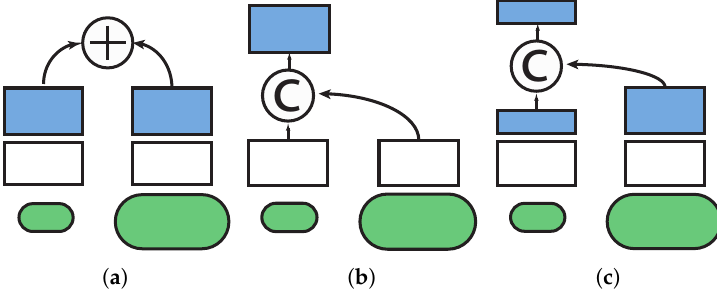
Figure 5. Different multi-scale structures in our experiment, ( a ) the features are summed up element-wise at the very end, ( b ) features are concatenated before fc_** layers and ( c ) features are concatenated between fc_** layers. Here green blocks indicate inputs of different scales, white indicates convolution layers, blue indicates fc_** layers, circle with a plus indicates element-wise addition operation of feature maps, circle with a C indicates concatenation operation. The loss layers are placed on the very top of each network.